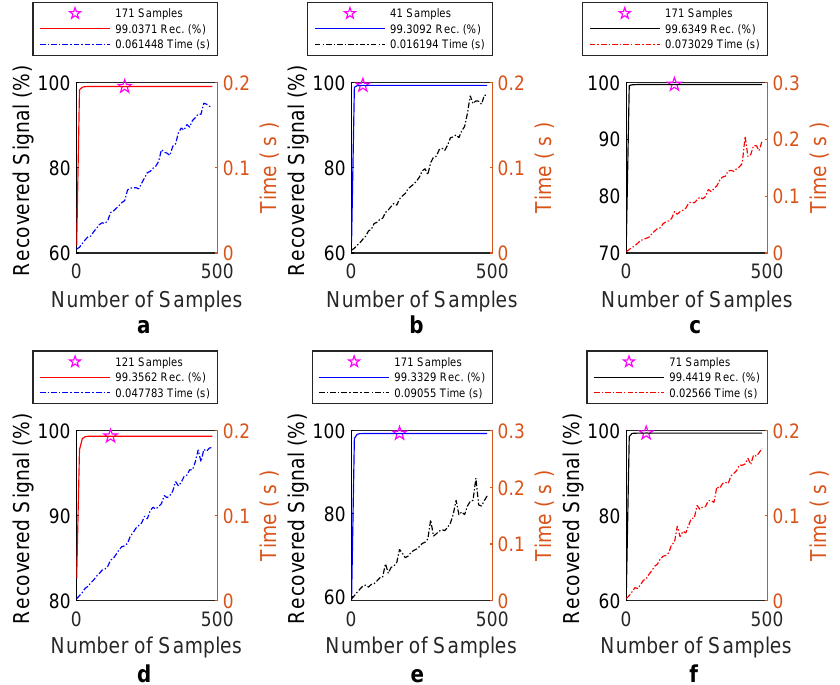
Figure 5. Calculation of the number of k atoms vs. processing time (( a – c ) current and ( d – f ) voltage at bus 4).